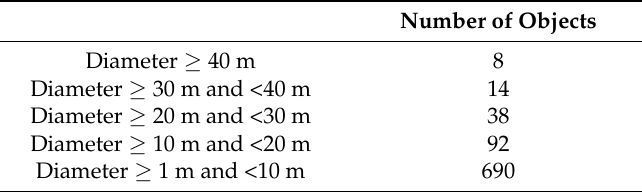
Table 2. Distribution of the diameters of the archaeological structure in the test